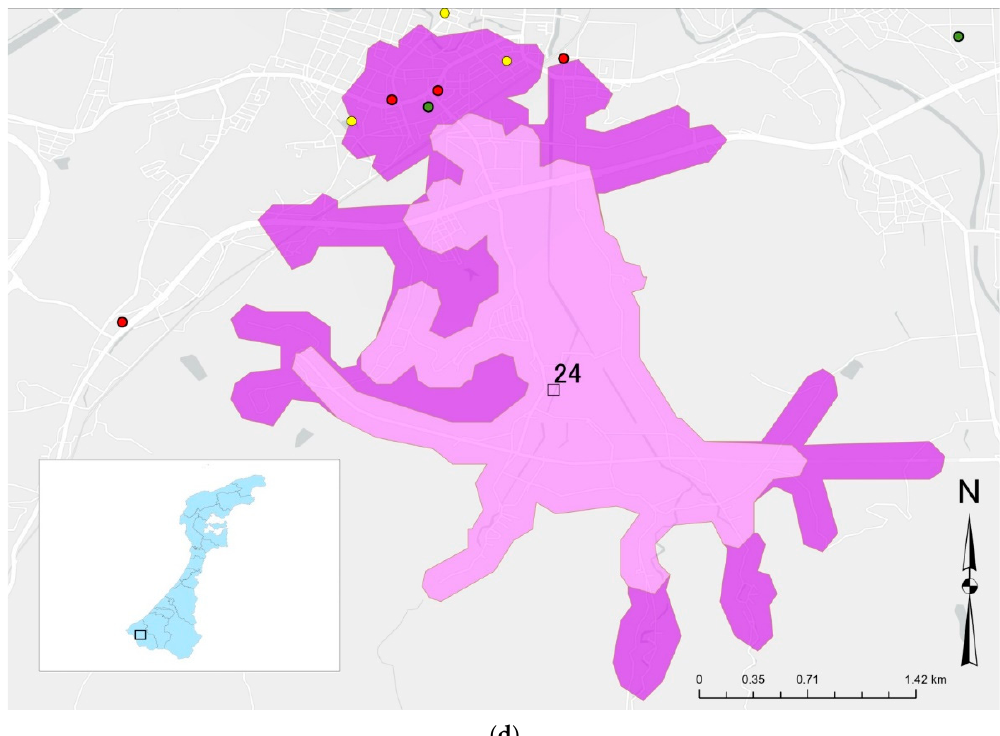
Figure 7. ( a ) GHs with no SPs in their ELAs for adults. ( b ) GHs with no SPs in their ELAs for adults (For legends, see Figure 7a). ( c ) GHs with no SPs in their ELAs for older adults (For legends, see Figure 7a). ( d ) GHs with no SPs in their ELAs for older adults (For legends, see Figure 7a).